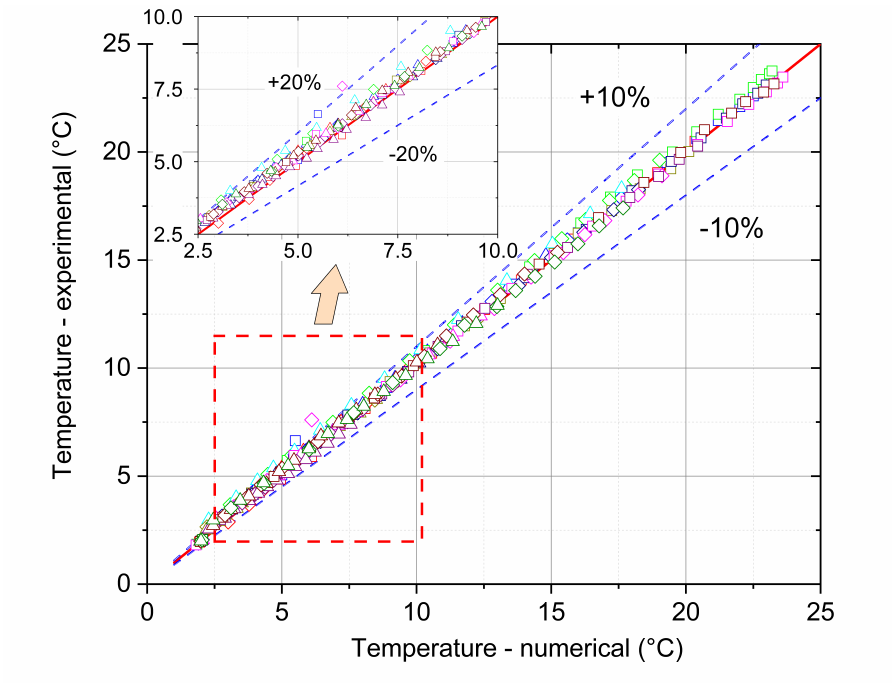
Figure 19. The comparison of numerical and experimental temperatures and obtained relative